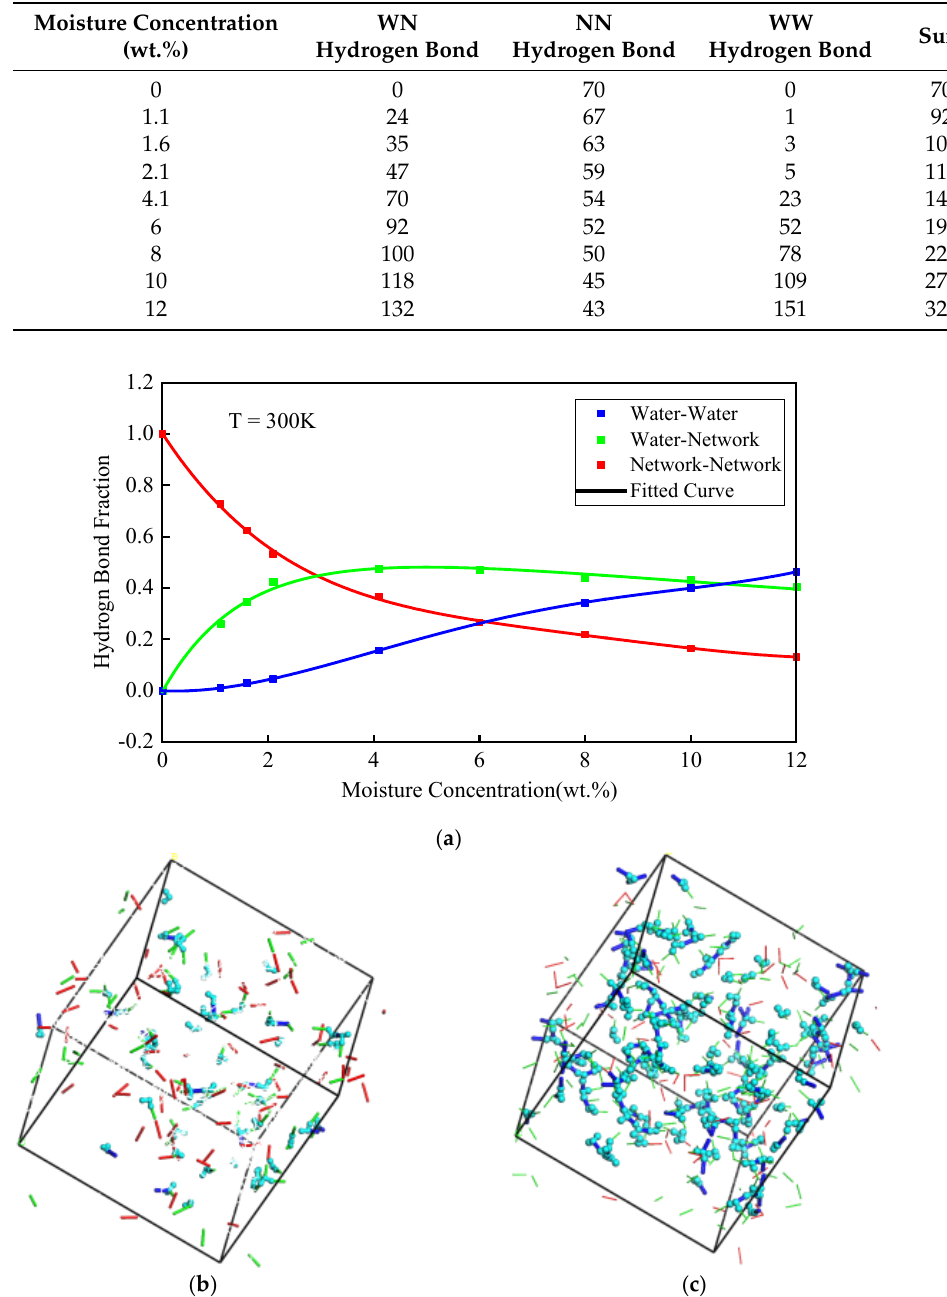
Table 1. Number of hydrogen bonds in the system at different moisture concentrations.